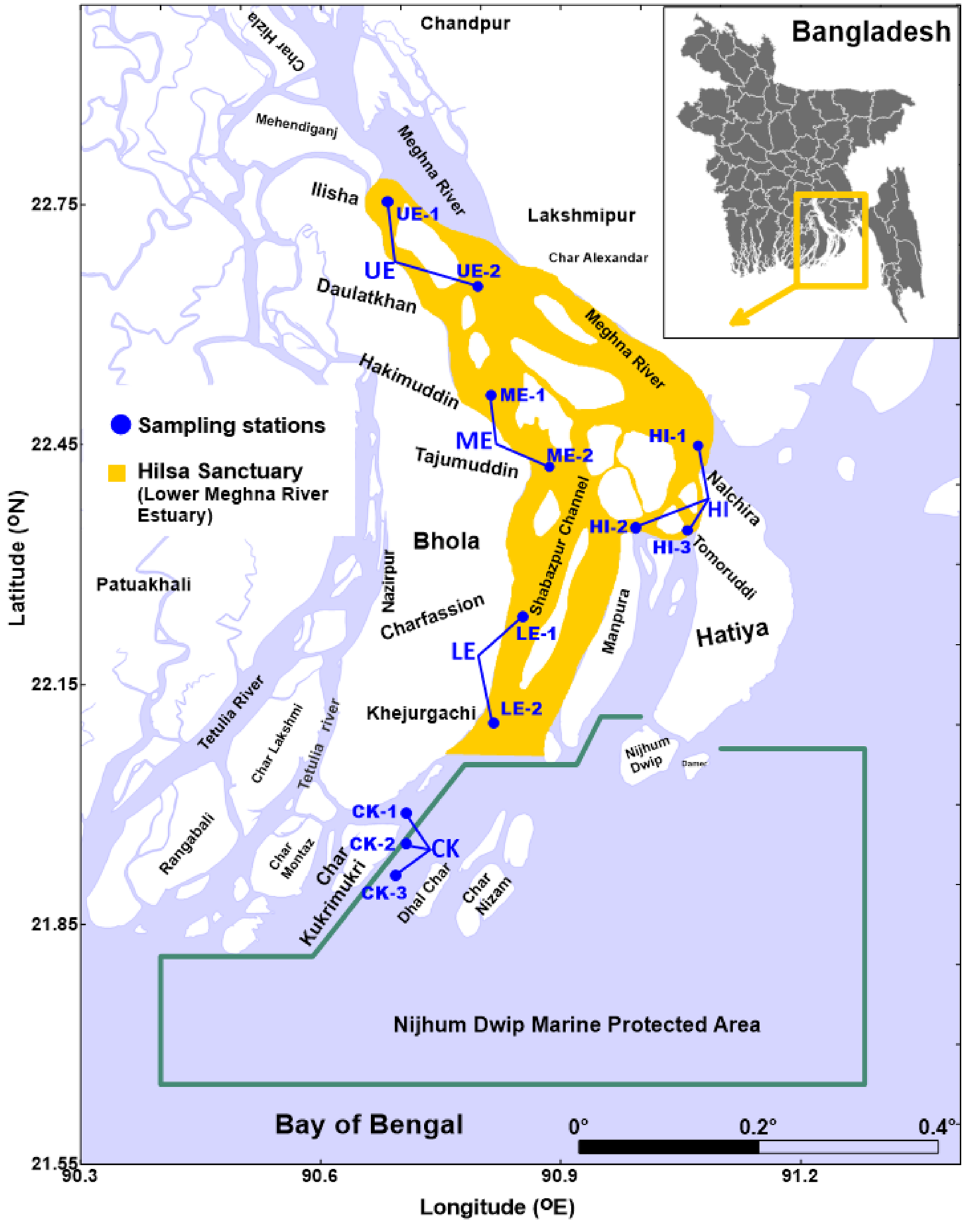
Figure 1. Map of the study area in the Meghna River estuary and its adjacent coastal area. The map was generated using QGIS (version 3.2.1, https:// www. qgis. org). Conductivity-temperature-depth (CTD) recorder and water samples collection stations shown as solid